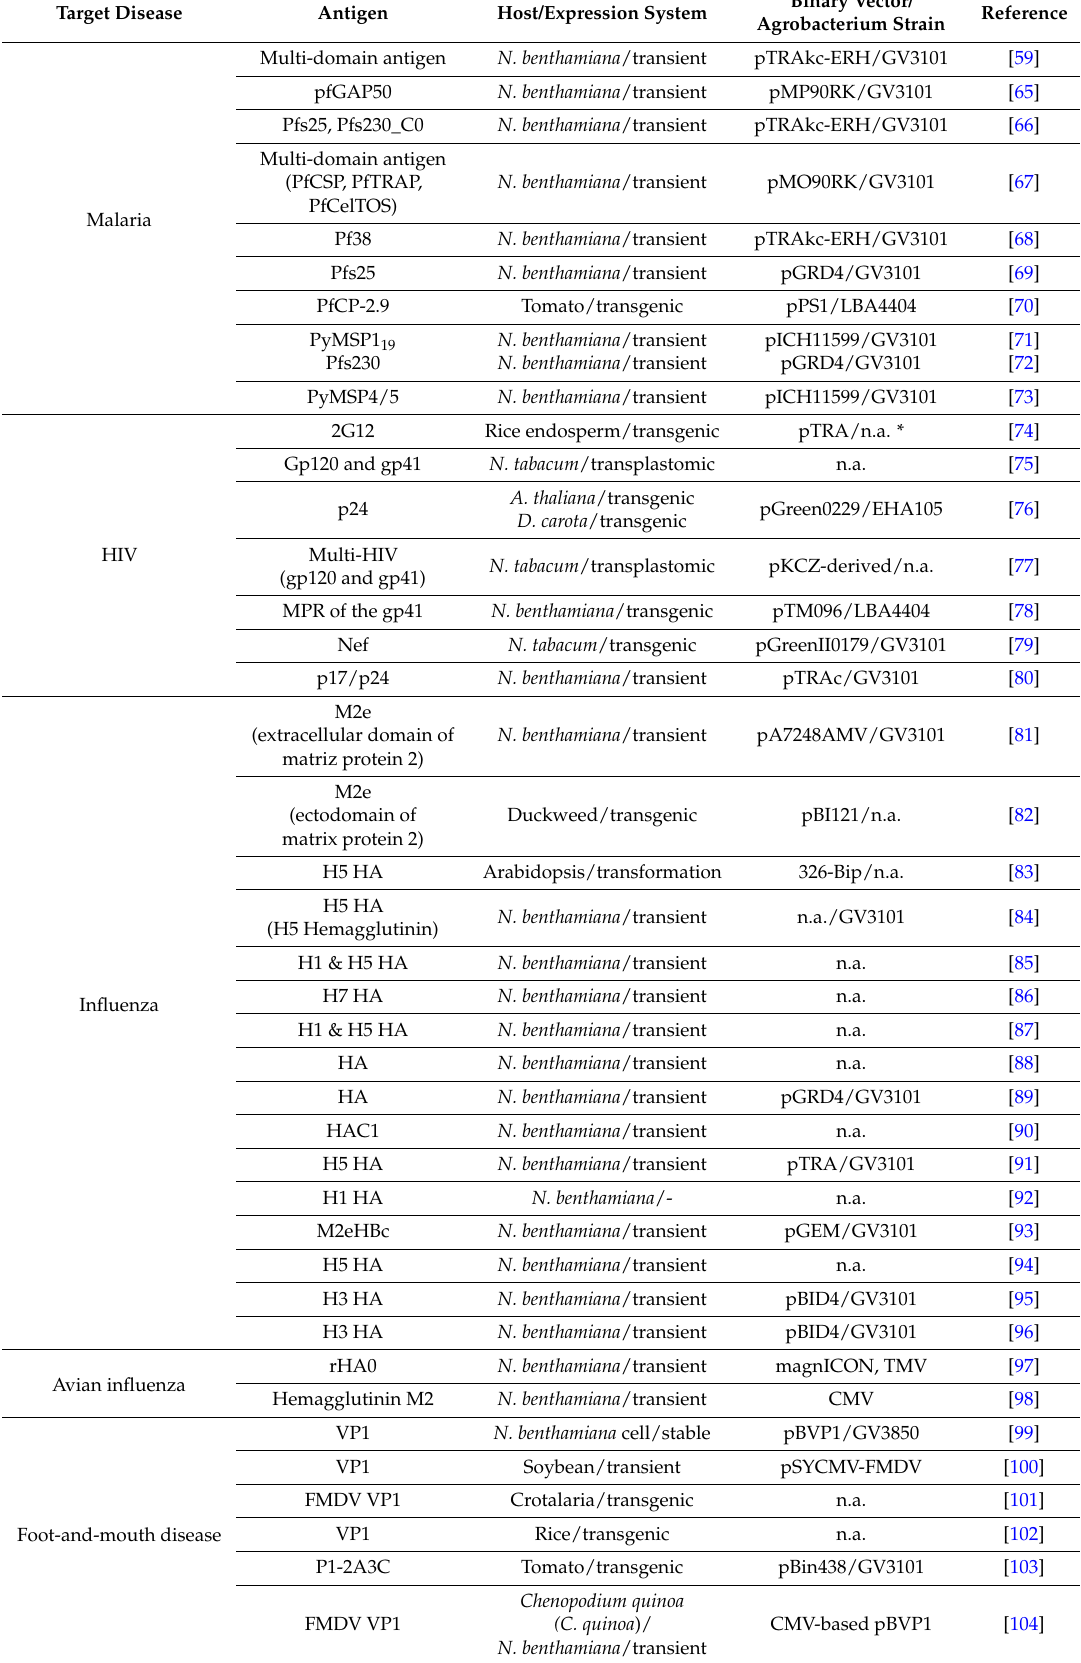
Table 2. Published studies on plant-derived antigens for last